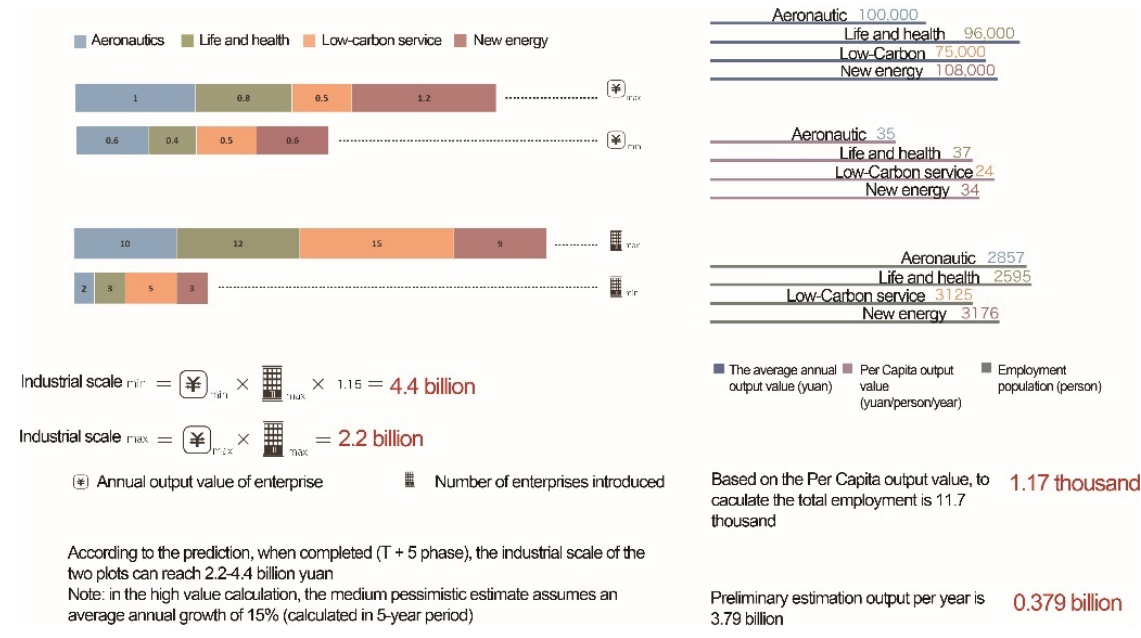
Figure 11. Output value estimation results of two land lots (Source: author).